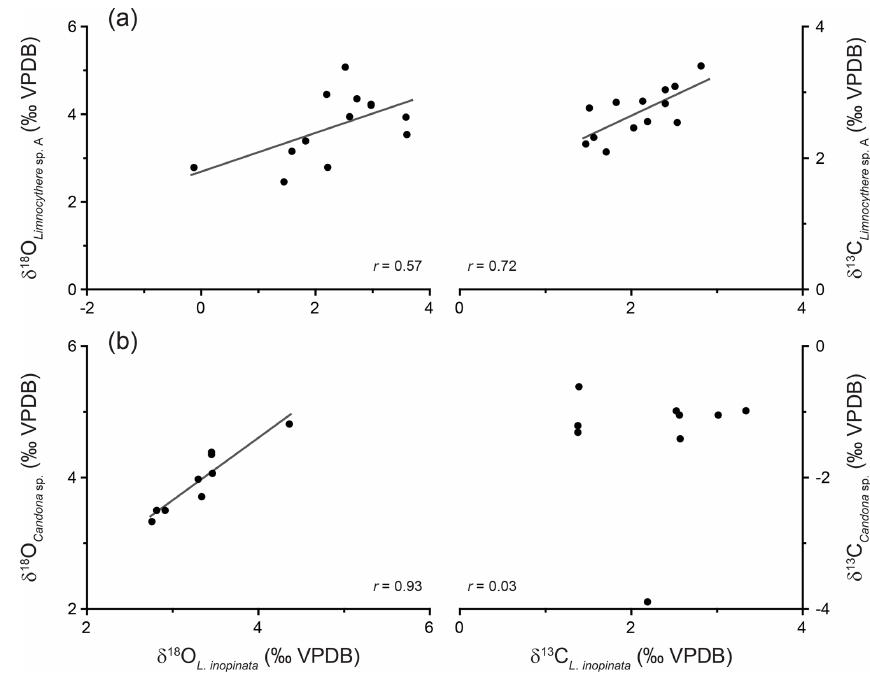
Figure 6. Isotopic composition of L. inopinata valves vs. Limnocythere sp. A (a) and Candona sp. (b)